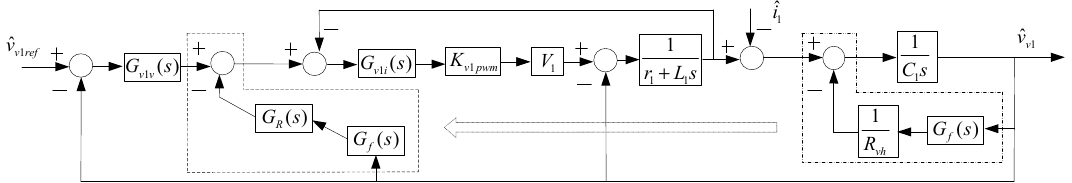
Figure 8. Adding a virtual harmonic resistance through the second-order generalized integrator (SOGI).